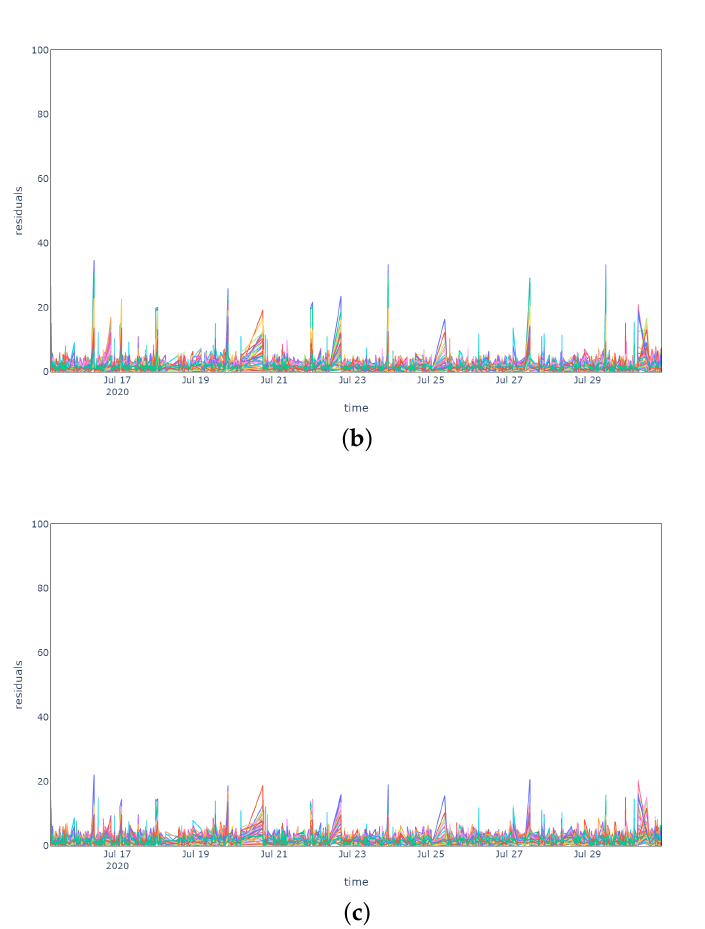
Figure 4. ( a ) shows the KPIs associated to all sensors without the removal of outliers in a normal operating condition period, while ( b , c ) represent the KPIs (5) over time after the IQR and MC methods were applied respectively for the outlier removal